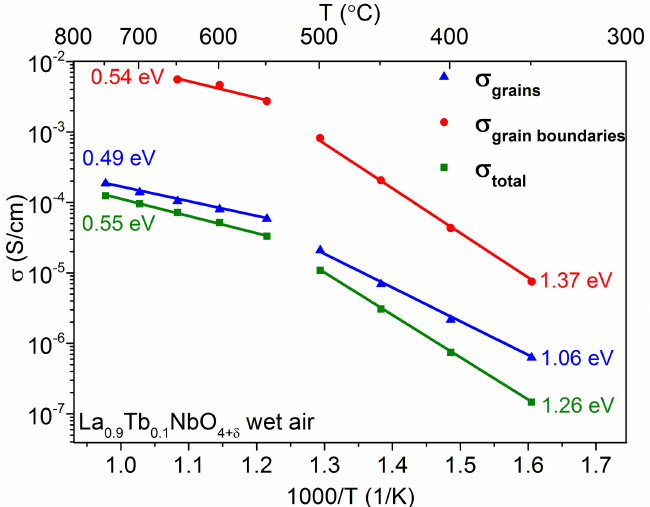
Figure 10. Temperature dependence of total conductivity, grain conductivity, and specific grain boundary conductivity of La 0.9 Tb 0.1 NbO 4+ δ measured in wet